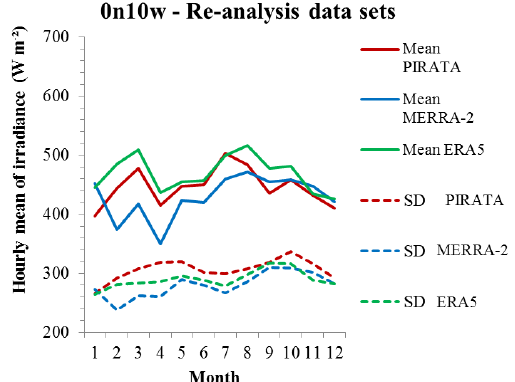
Figure B6. Monthly means (solid lines) and standard deviations (dotted lines) of hourly DSIS, in Wm − 2 , from PIRATA measurements (red) and data sets (MERRA-2: blue, ERA5: green) at 0 ◦ N, 10 ◦ W. A difference between red line (measurements) and coloured line (data set) for a given month denotes a systematic error for this month: underestimation if the coloured line is below the red line, overestimation otherwise. For a given month, a coloured dotted line above the red one means that the data set produces too much variability for this month; in the opposite case, the data set does not contain enough